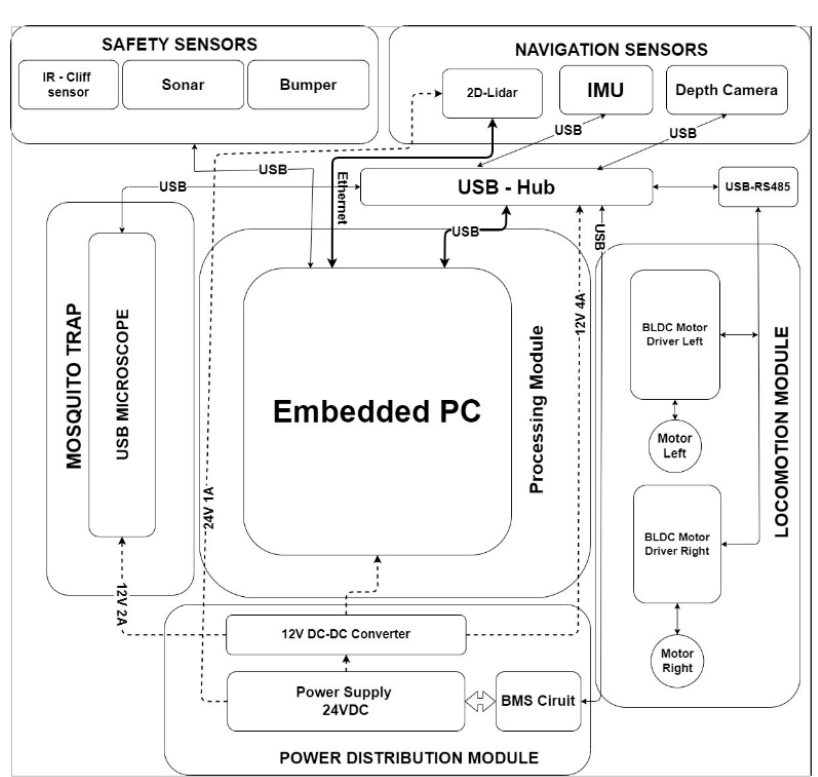
Figure 3. System